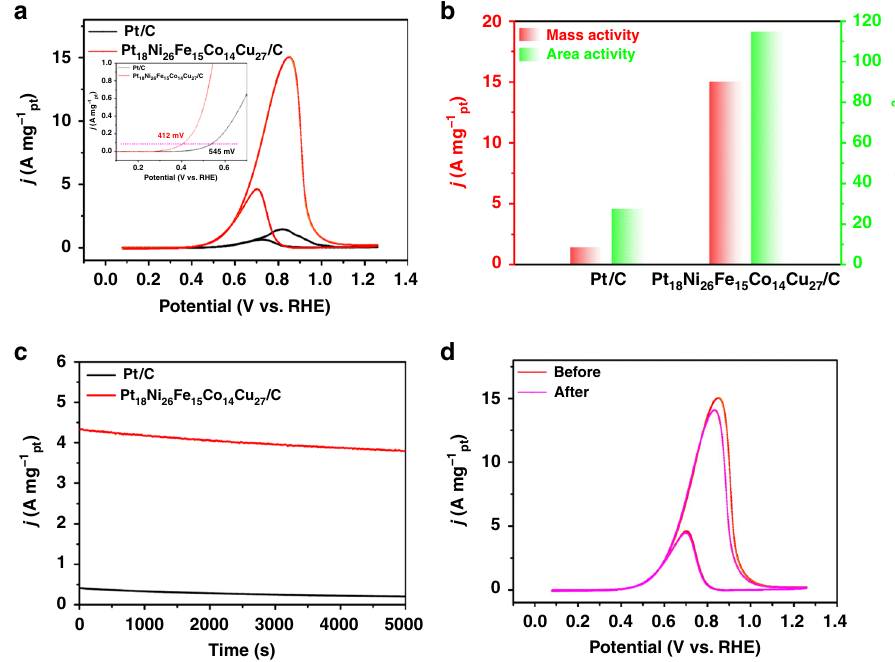
Fig. 3 Methanol electro-oxidation performance of the Pt 18 Ni 26 Fe 15 Co 14 Cu 27 /C and Pt/C in 1 M KOH + 1 M CH 3 OH electrolyte. a CV curves (the inset is the onset potential, the mass activity of 0.1 A mg − 1 pt ) of Pt/C and Pt 18 Ni 26 Fe 15 Co 14 Cu 27 /C. b Peak values of mass activity and area activity. c Chronoamperometric tests for MOR at 0.65 V vs. RHE. d CV curves of the Pt 18 Ni 26 Fe 15 Co 14 Cu 27 /C before and after 1000